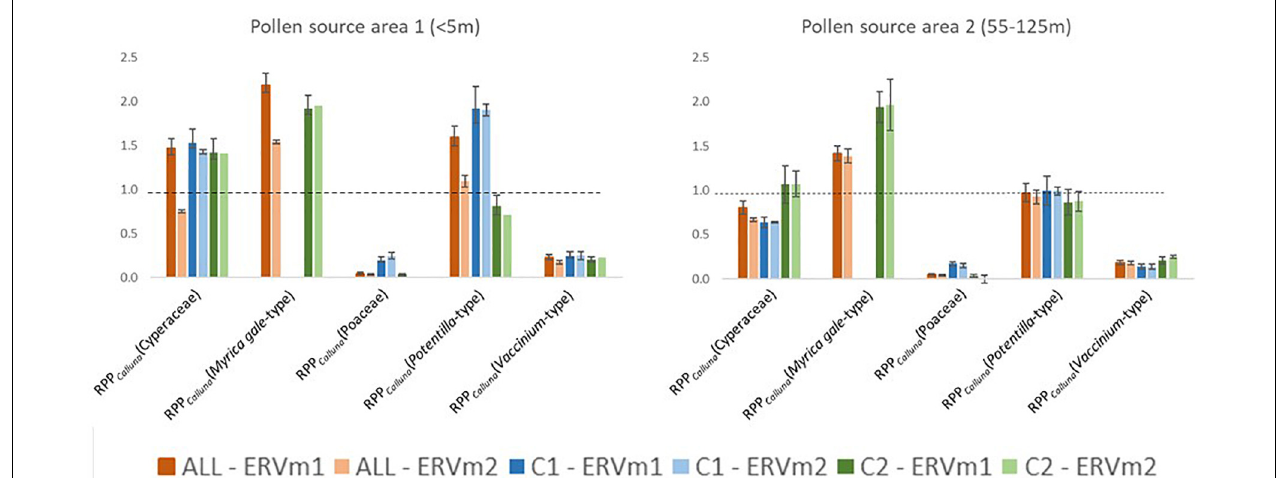
FIGURE 7 | Comparison of estimates of Relative Pollen Productivity (reference taxon is Calluna vulgaris ) obtained using different combinations of sample dataset (ALL = all samples, C1 = Cluster 1, C2 = Cluster 2—see Figure 3 for definition of clusters) and Extended R Value sub-model (ERVm1 = Extended R-Value sub-model 1)—see text for details. Dashed line at 1.0.